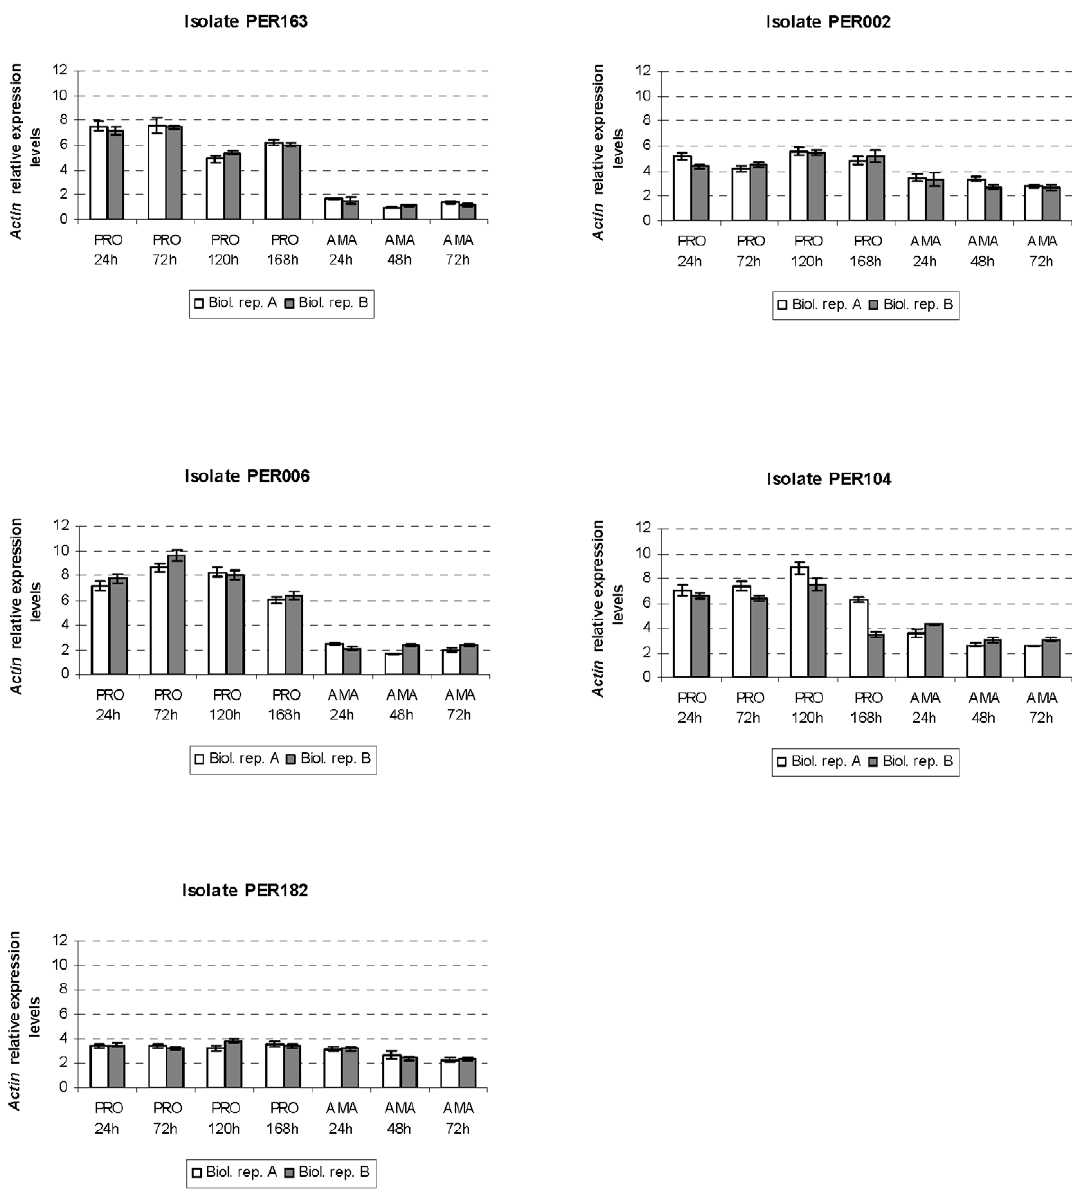
Figure 4. Variation in Actin gene expression throughout invitro growth and differentiation of promastigotes and intracellular amastigotes of L.braziliensis isolates studied (see legend of figure 2).